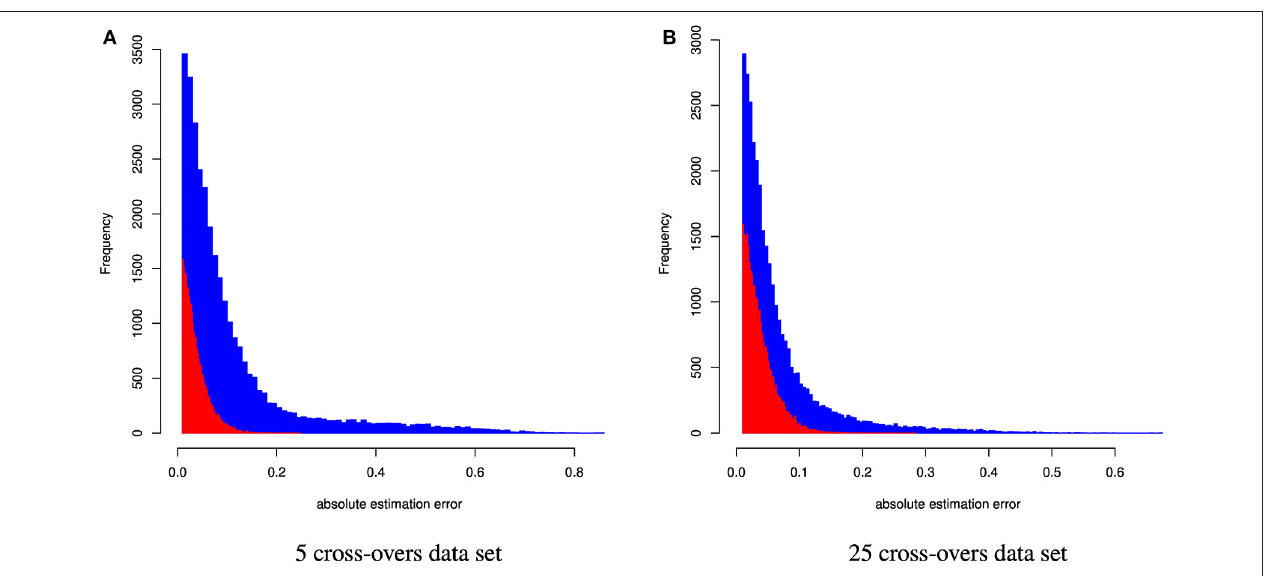
Frontiers in Genetics |